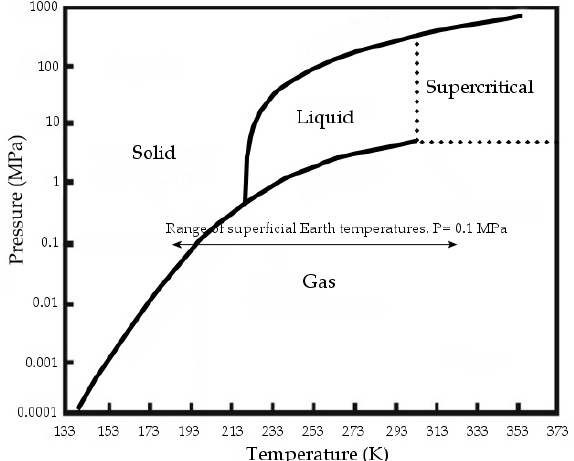
Figure 1. CO 2 phase diagram, modified from [1].